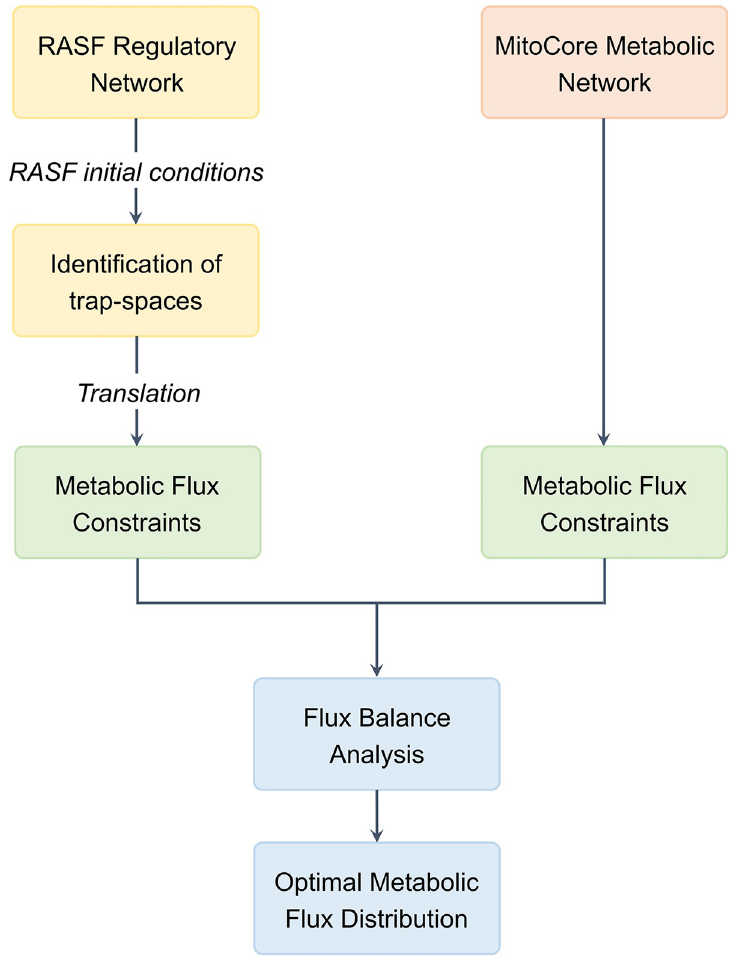
Fig 1. General architecture of the hybrid modeling